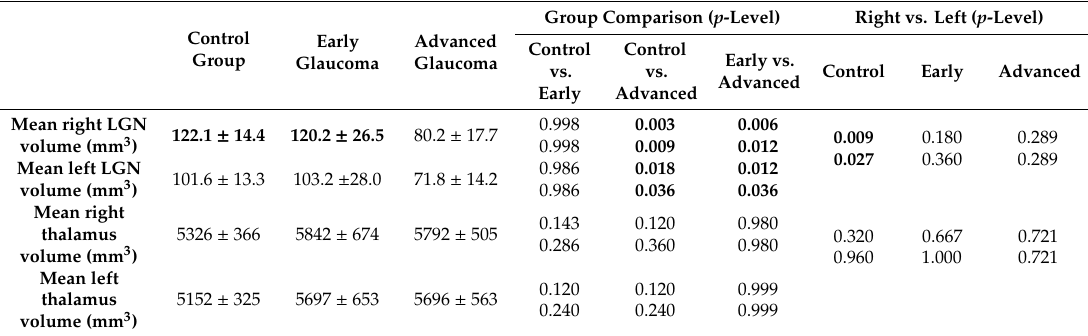
Values form Table 4 were obtained using: one-way ANOVA statistical analysis used for group comparison (Kruskal–Wallis and Tukey’s test) and t-test used for intragroup comparison of right and left LGN and thalamic volumes. Second row of p -values are obtained after Holm–Bonferroni